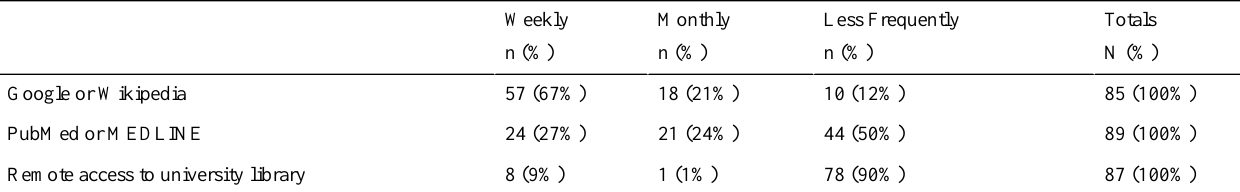
Table 3. Search strategy